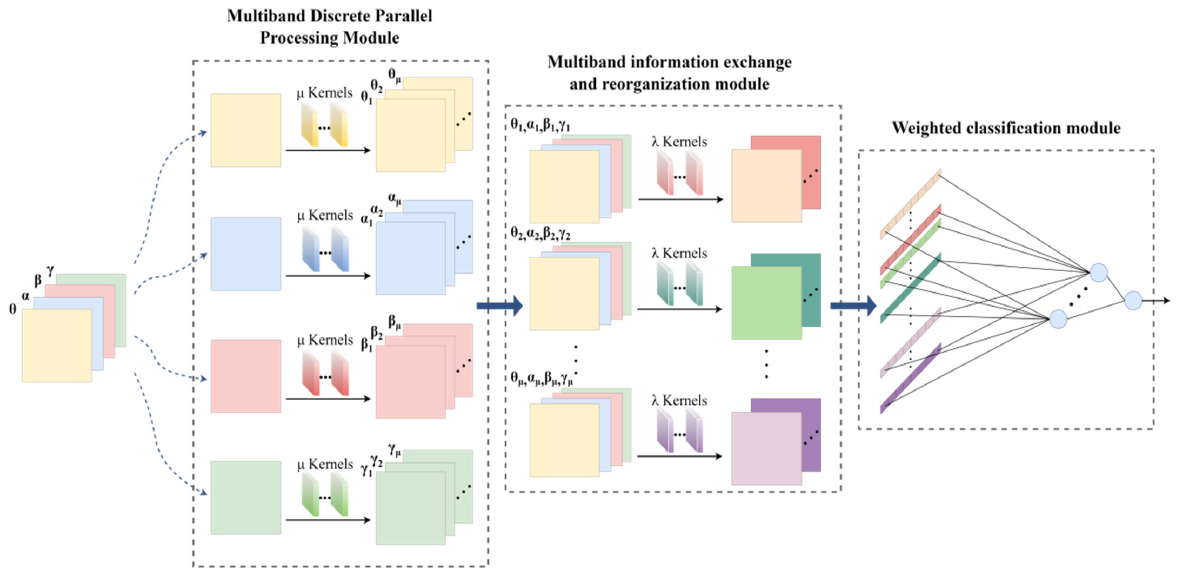
Figure 4. The structure of ERENet.